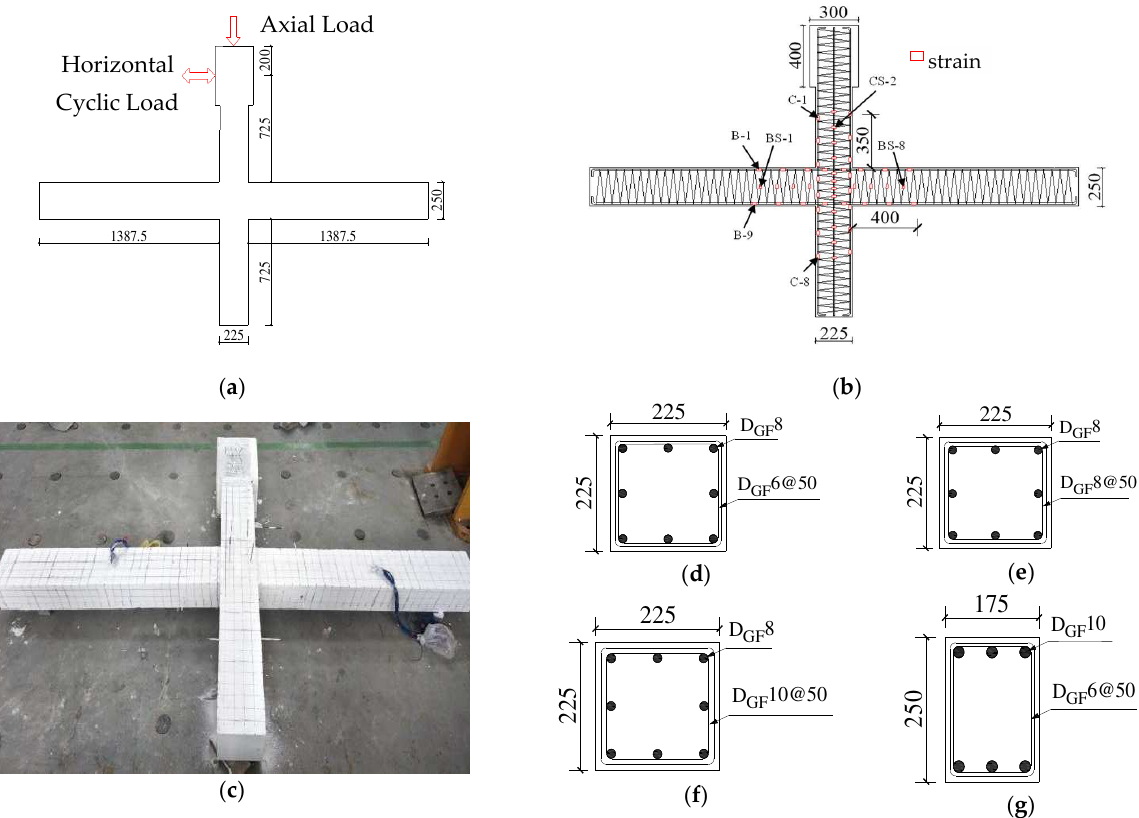
Figure 3. Details of test specimens (units: mm) ( a ) Dimensions of test specimens; ( b ) GFRP-RC specimens; ( c ) Photo of the joints; ( d ) Column BC-2; ( e ) Columns BC-5~BC-9; ( f ) Column BC-4; ( g ) GFRP-RC Beam.